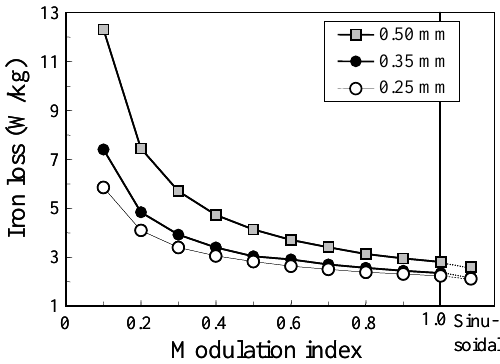
Figure 10. Dependence of iron loss on modulation index under PWM excitation. Maximum flux density: 1.5 T, fundamental frequency: 50 Hz, carrier frequency: 1.0 kHz.